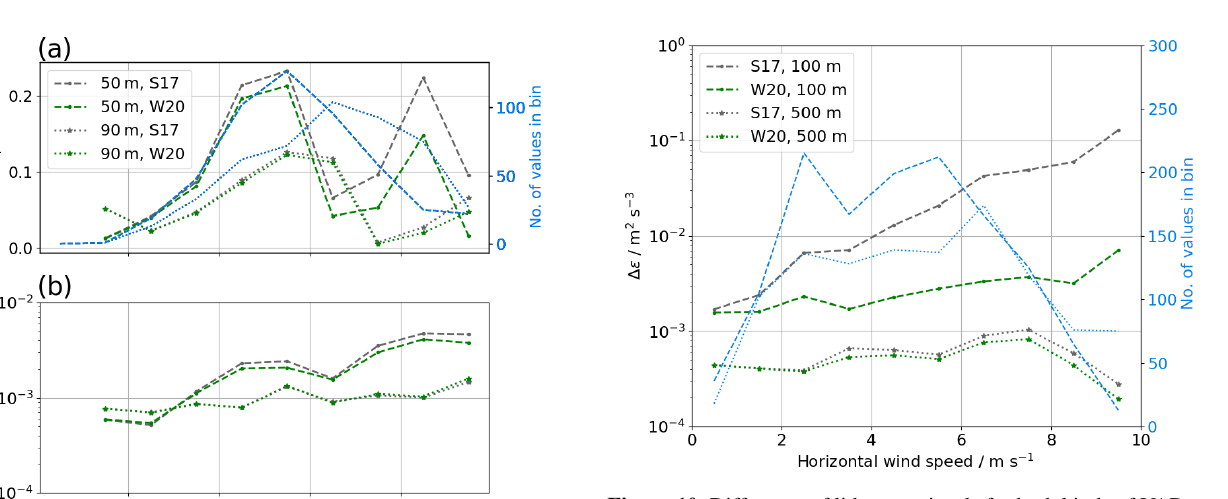
ence between the two elevation angles at the 500 m level is only reduced very little in the W20 method.